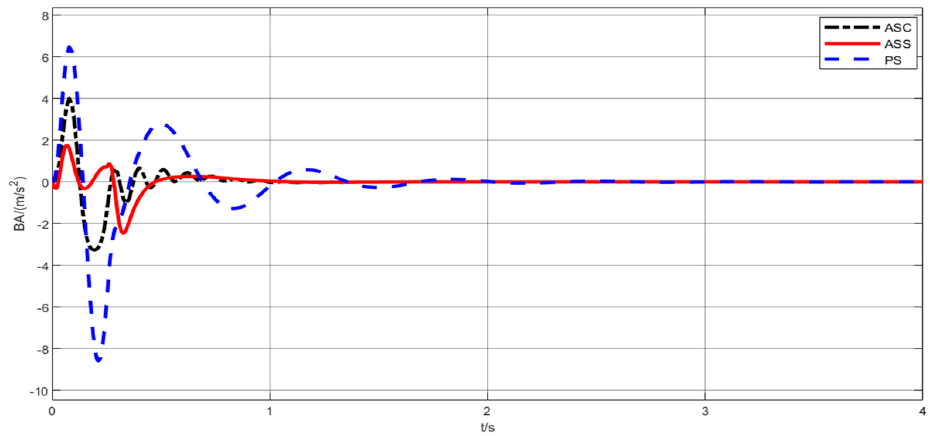
Figure 12. Bump dynamic tire displacement responses of different suspensions.